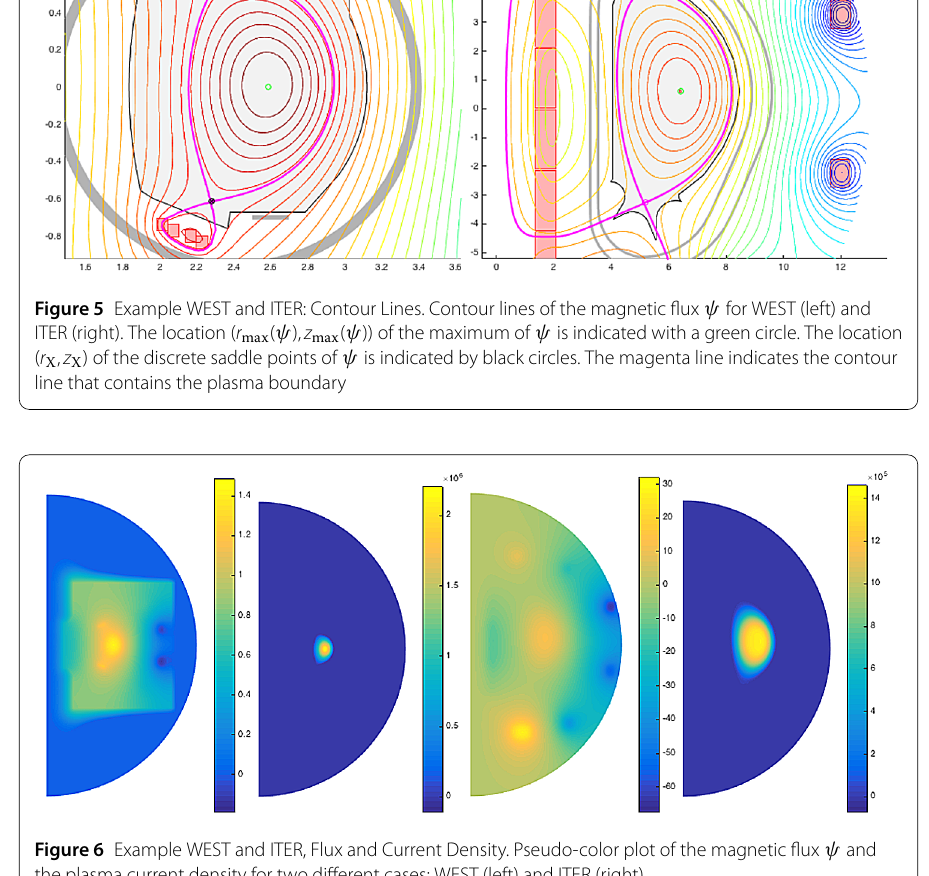
Figure 6 Example WEST and ITER, Flux and Current Density. Pseudo-color plot of the magnetic flux ψ and the plasma current density for two different cases: WEST (left) and ITER